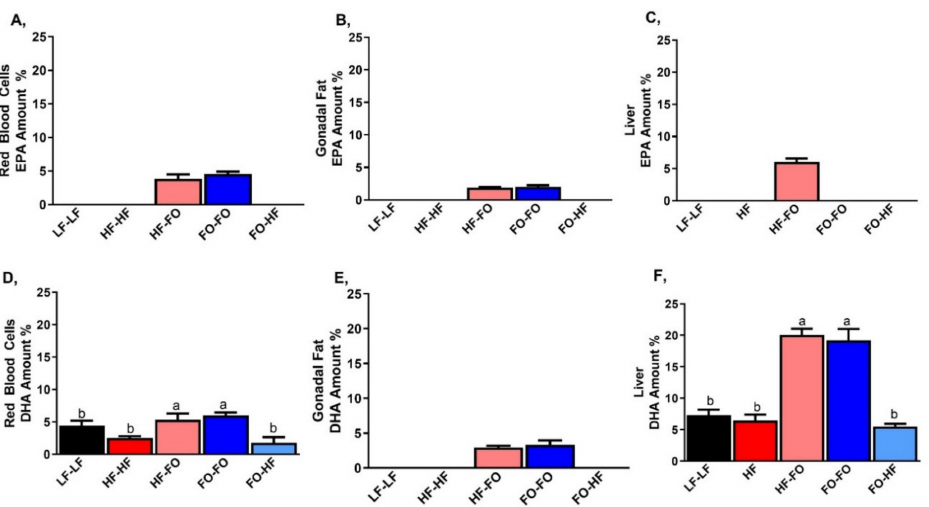
Figure 11. Incorporation of omega-3 fatty acids in serum and tissues: Amount of eicosapentaenoic acid (EPA) incorporation into ( A ) Blood ( B ) White adipose tissue (gonadal fat) and ( C ) Liver. Similarly, amount of docosahexaenoic acid (DHA) into ( D ) Blood ( E ) gonadal fat and ( F ) Liver. Data is presented as mean ± SEM (n = 4). Common letters on the error bars indicate no significance (e.g., “a” is significantly different from “b” and “ab” indicates no significance compared to “a” and